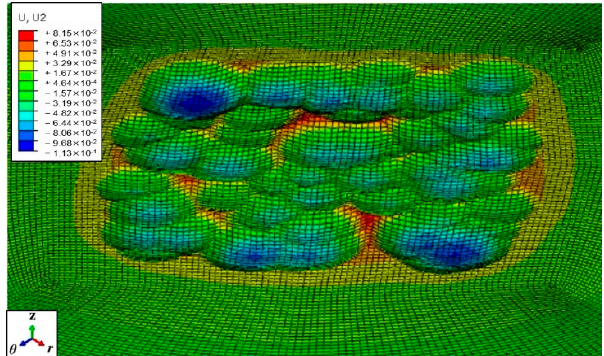
Figure 8. Vertical displacements of the surface nodes after multiple shots peening.